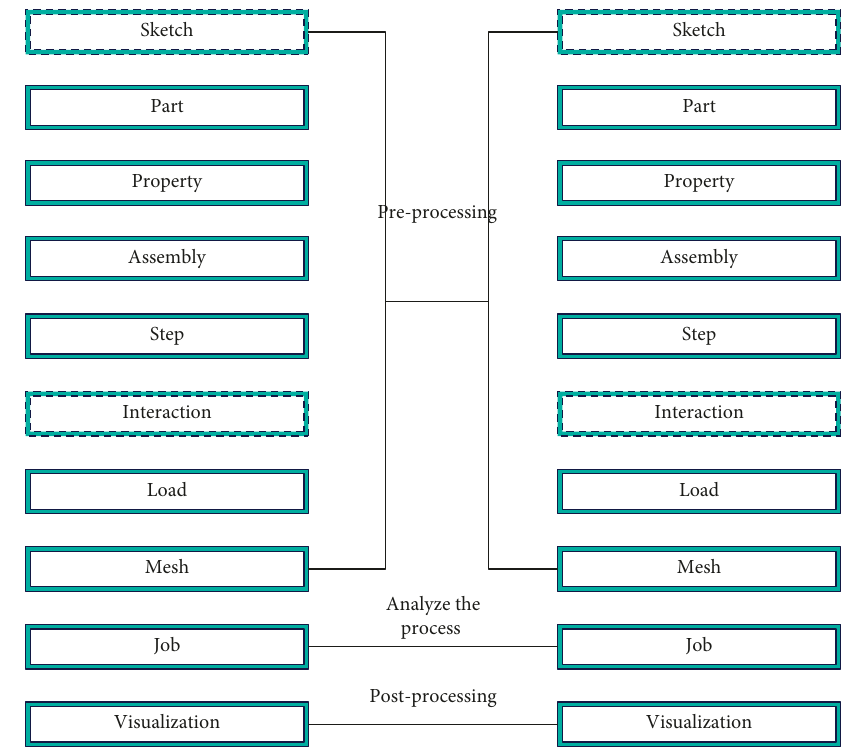
Figure 5: Finite element modeling process.